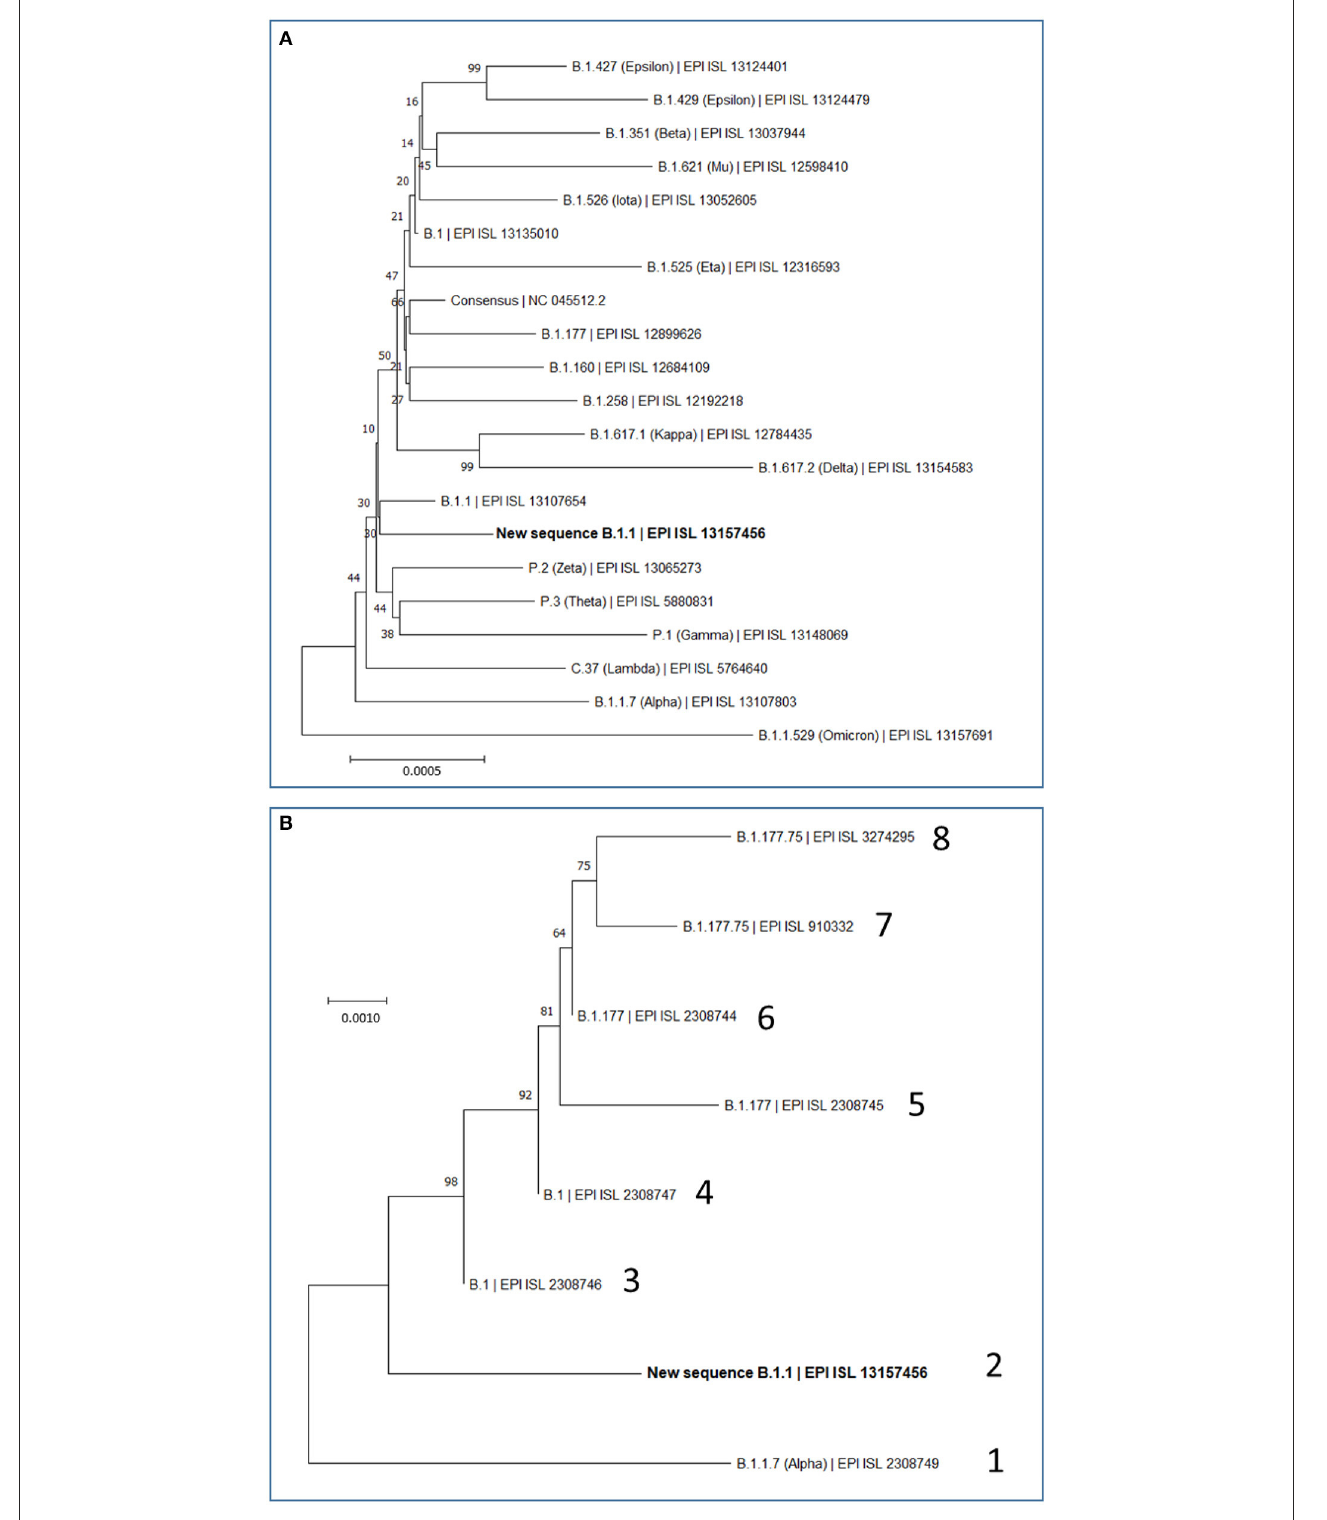
FIGURE2 Maximum Likelihood Trees based on complete SARS-CoV-2 genomes. Evolutionary analyses were conducted in MEGA (see Methods), inferring the histories using the neighbor-joining method. Optimal trees are shown. The percentage of replicate trees in which the associated taxa clustered together is shown next to the branches. The scale bars measure phylogenetic distances as the indicated nucleotide substitutions per site. Optimal trees are shown. Trees are drawn to scale, with branch length in the same units as those of the evolutionary distance used to infer the phylogenetic tree. (A) Phylogenetic relations of our new B.1.1 sequence in the context of the most relevant SARS-CoV-2 variants, including variants which during the pandemic have been considered at least once as VOCs (Alpha, Beta, Gamma, Delta and Omicron) or VOIs (Epsilon, Mu, Iota, Eta, Kappa, Zeta, Theta, and Lambda), and also including the most prevalent variants (B.1, B.1.177, B.1.160, and B.1.258) that were circulating in Europe before the collection date of our study’s sample.